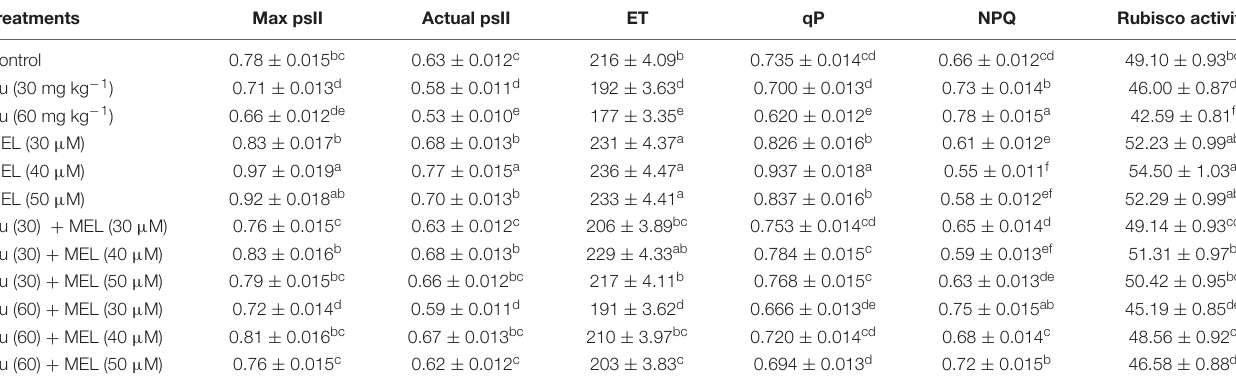
TABLE 3 | Effect of different levels of soil applied Cu (0, 30, or 60 mg kg − 1 ) and/or MEL (30, 40, or 50 µ M) on maximum PSII efficiency (Max psII), actual PSII efficiency (Actual psII), electron transport rate (ET), photochemical quenching (qP), non-photochemical quenching (NPQ), and Rubisco activity ( µ mol CO 2 protein min − 1 ) of Brassica juncea at 45